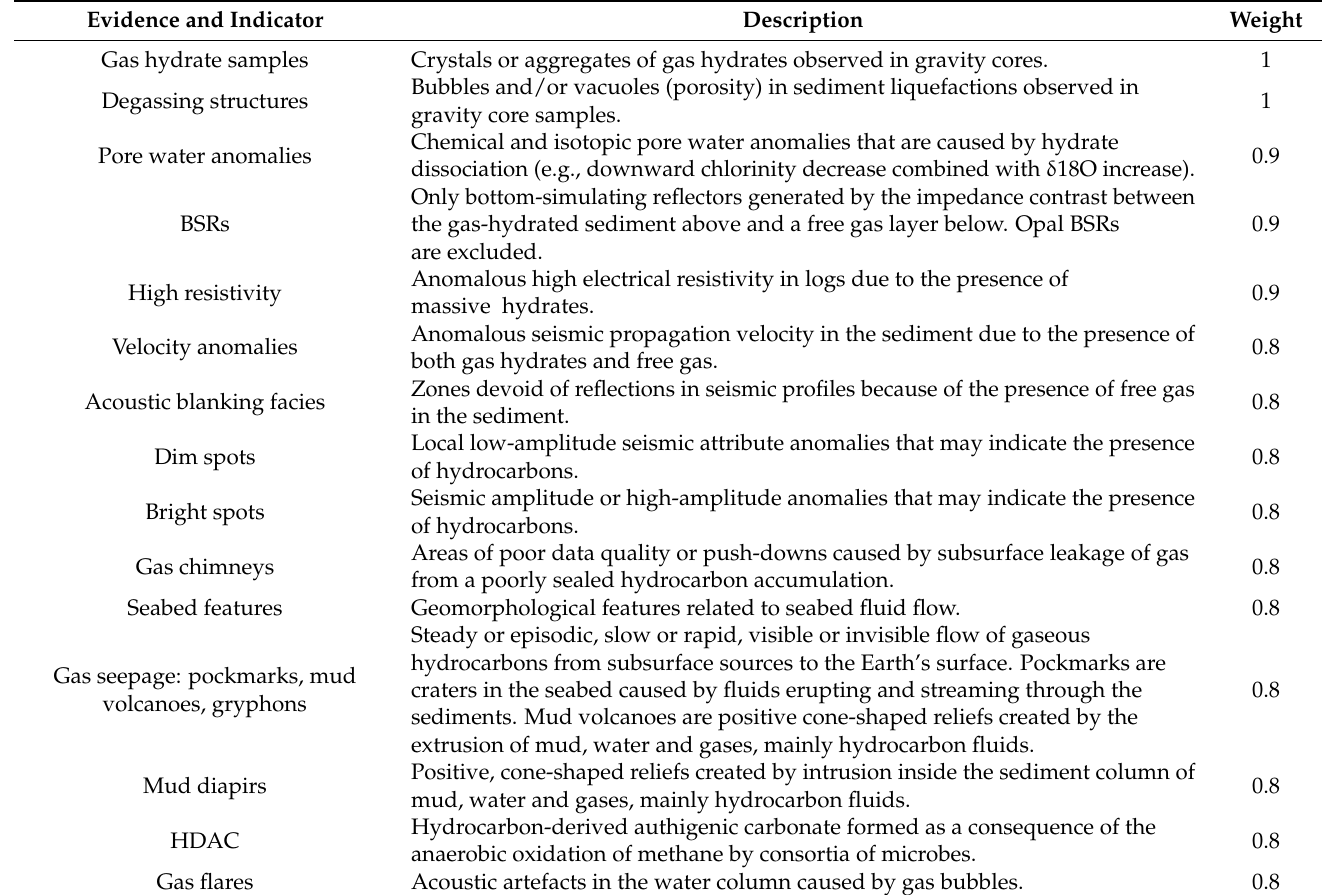
Table 3. Weights given to each hydrate-related item of evidence or indicator for the development of the density map of